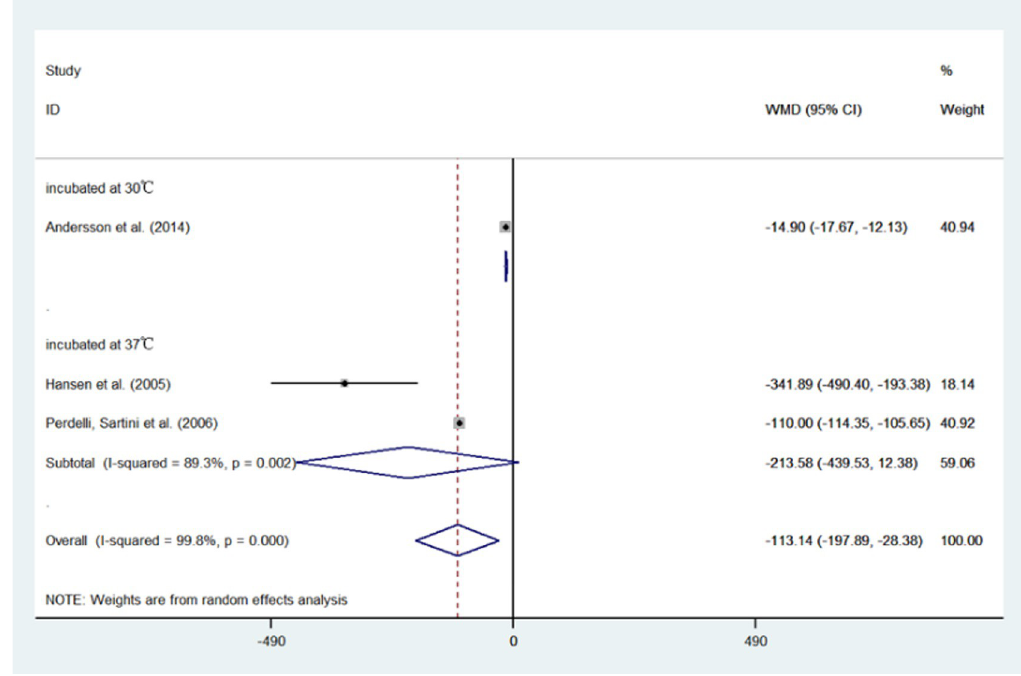
Fig 7. Forest plots of comparing the mean bacterial colony forming units per cubic meter (CFU/m 3 ) in rooms with HEPA vs rooms without